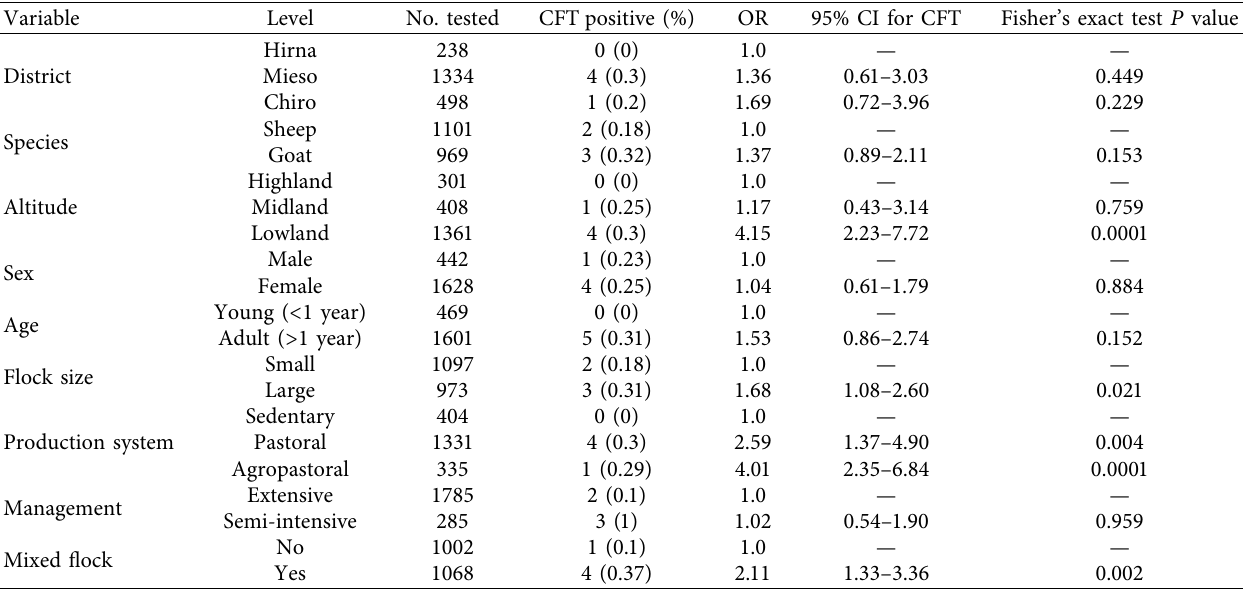
Table 2: Univariable logistic regression analyses of explanatory variables of small ruminant brucellosis.